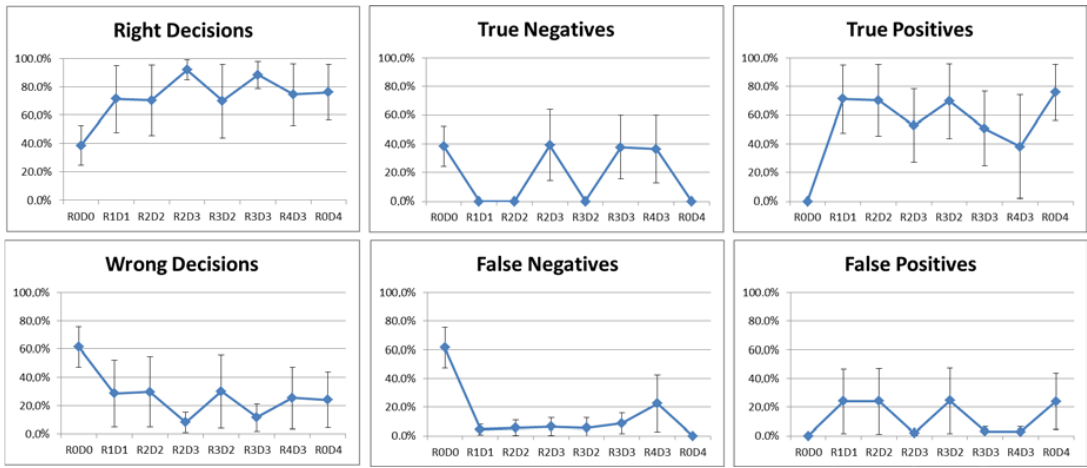
Figure 8. Betrayal attack for Restricted Scenario experiments.